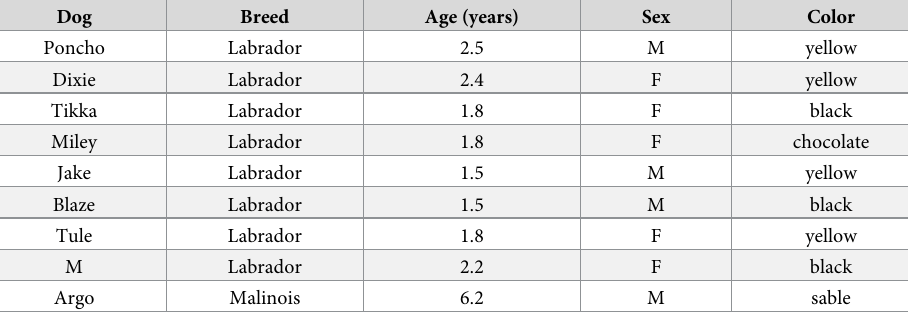
Table 1. Detection dogs used in this